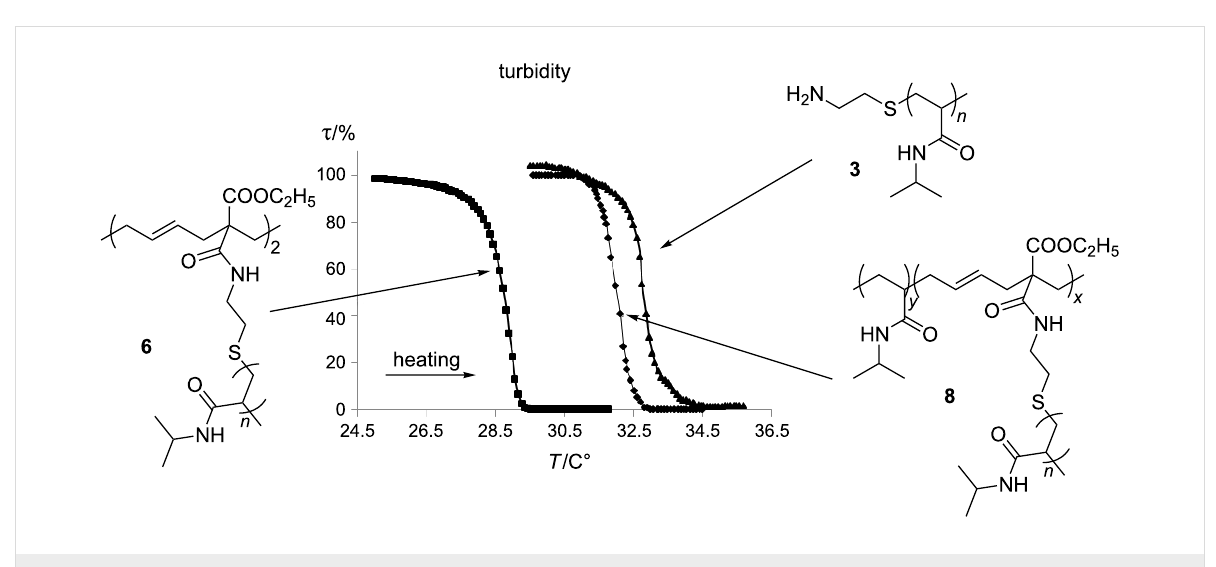
Figure 2: Optical transmittance of aqueous solutions ( c = 20 mg/mL) of 3 , 6 und 8 during heating.